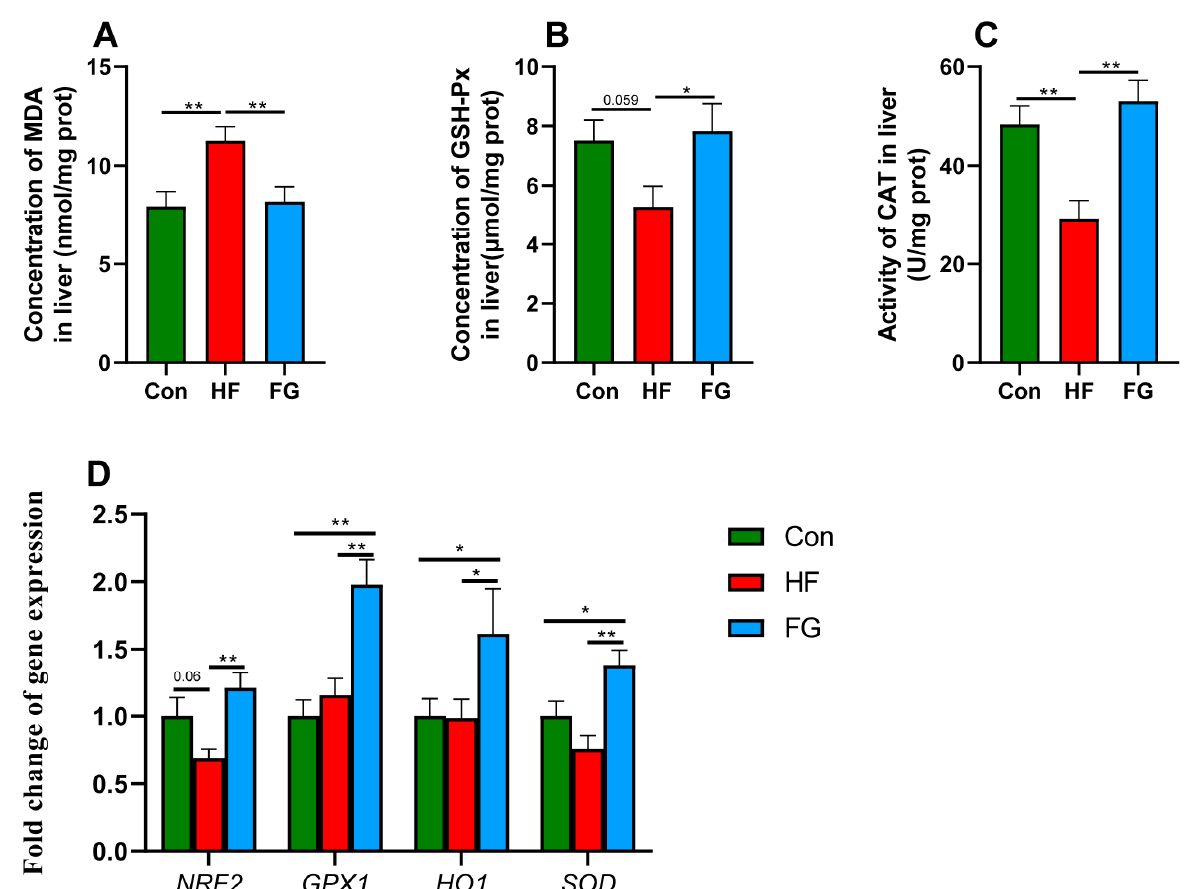
Figure 3. Effects of dietary fat level and GABA supplementation on liver MDA content ( A ), GSH-Px content ( B ), CAT activity ( C ), and the expression of antioxidant-related genes ( D ). Data are presented as mean ± SEM, * p < 0.05, ** p < 0.01. MDA, malondialdehyde; GSH-Px, glutathione